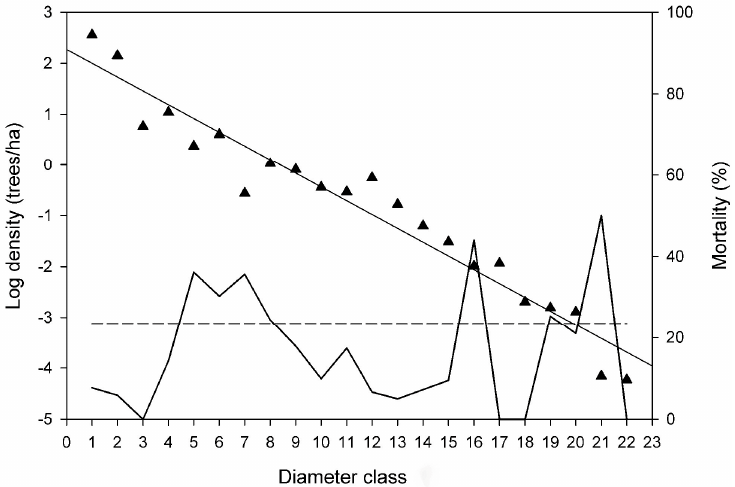
Figure 1. Log-linear plot of a hypothetical diameter distribution (  ), the baseline mortality calculated from the log-linear plot (- - -), and hypothetical currently observed mortality by diameter class (solid line without